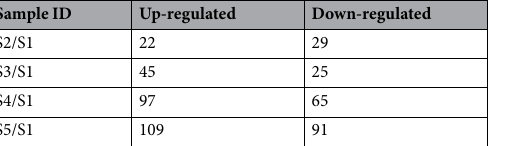
Table 1. Summary of differentially quantified proteins ( > 1.3, or < 0.77) Control sample (S1); sample